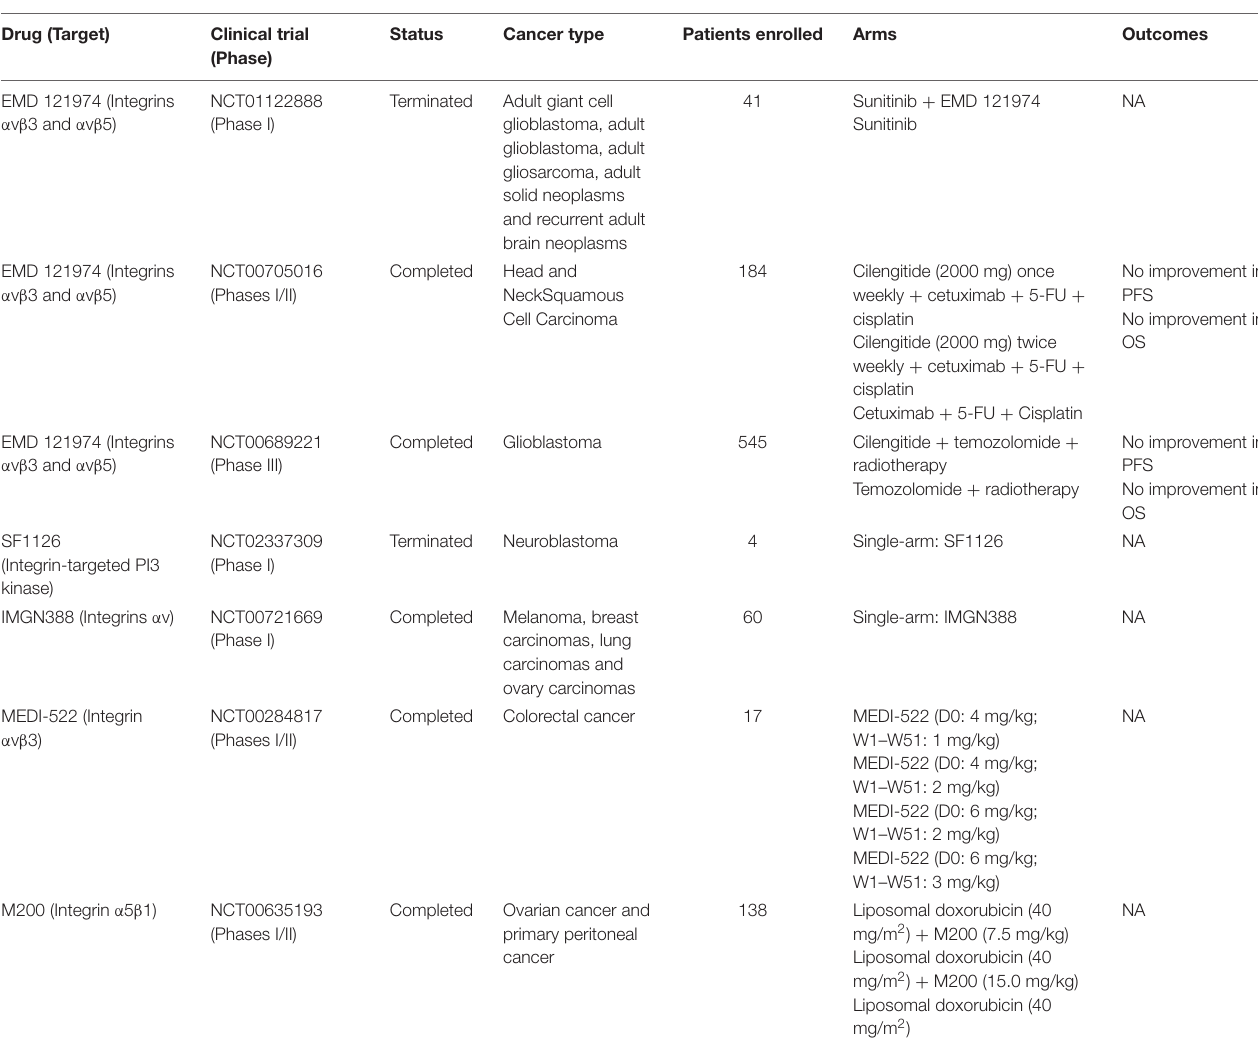
TABLE 2 | Overview of anti-TGF- β therapies based on integrin inhibitors used in cancer clinical trials. Drug